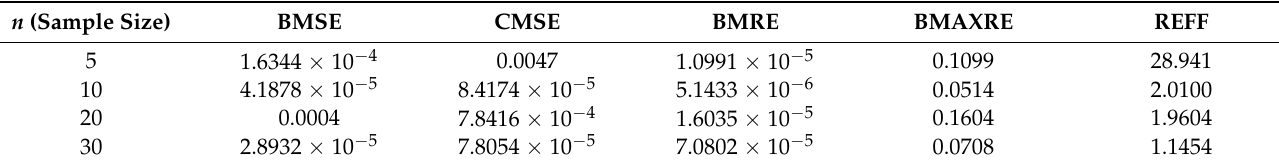
Table 8. Estimation efficiency: numerical results for case B1.